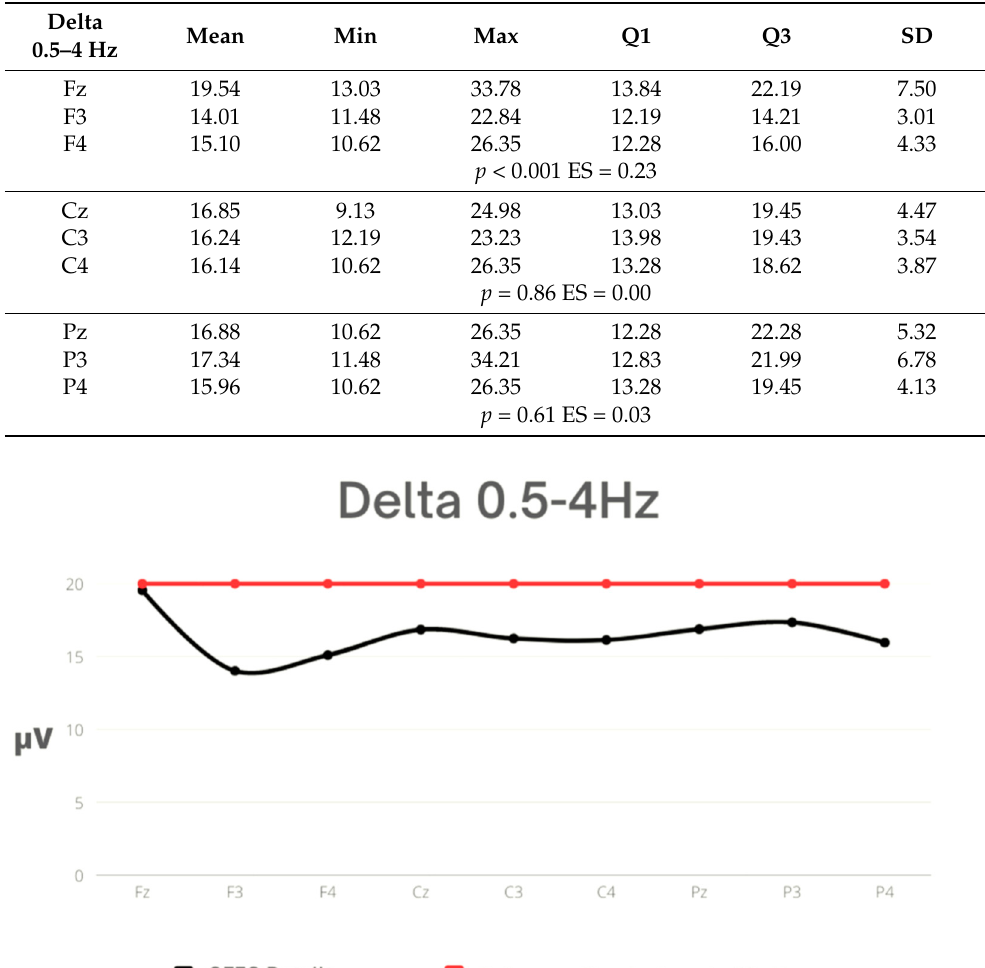
Figure 1. Mean values for Delta against the reference standard.